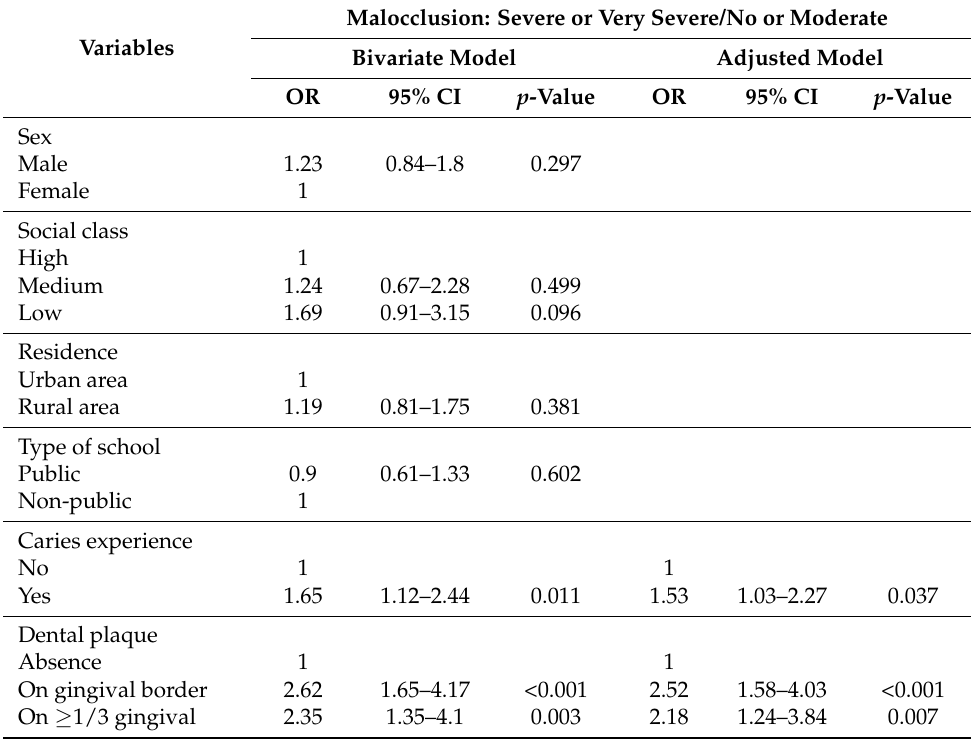
Table 6. Malocclusion risk in 15-year-old schoolchildren using bivariate and multivariate logistic regression models.